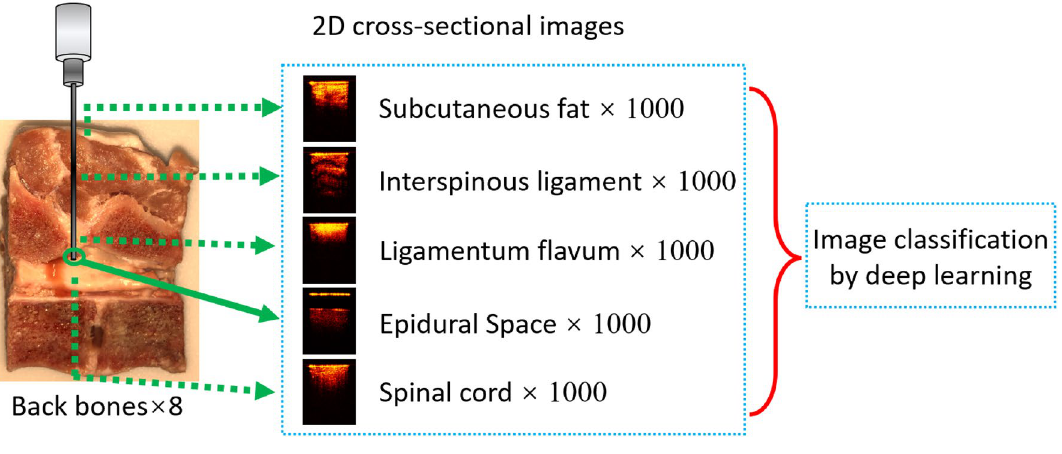
Figure 5. Data acquisition